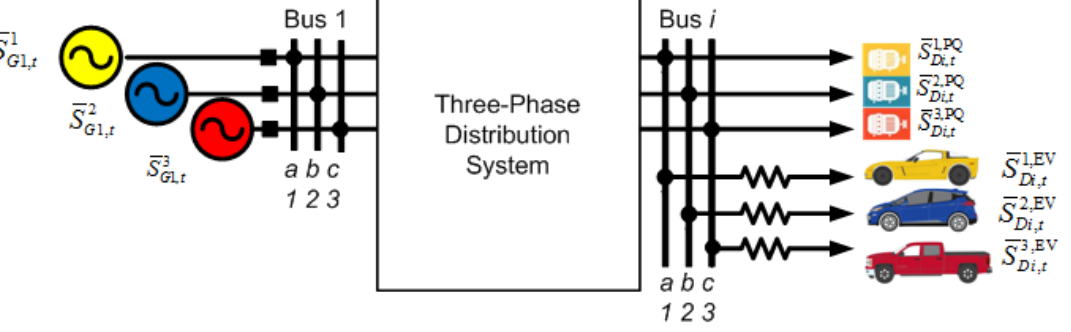
Figure 1. Three-phase distribution system with Electric Vehicles (EV)